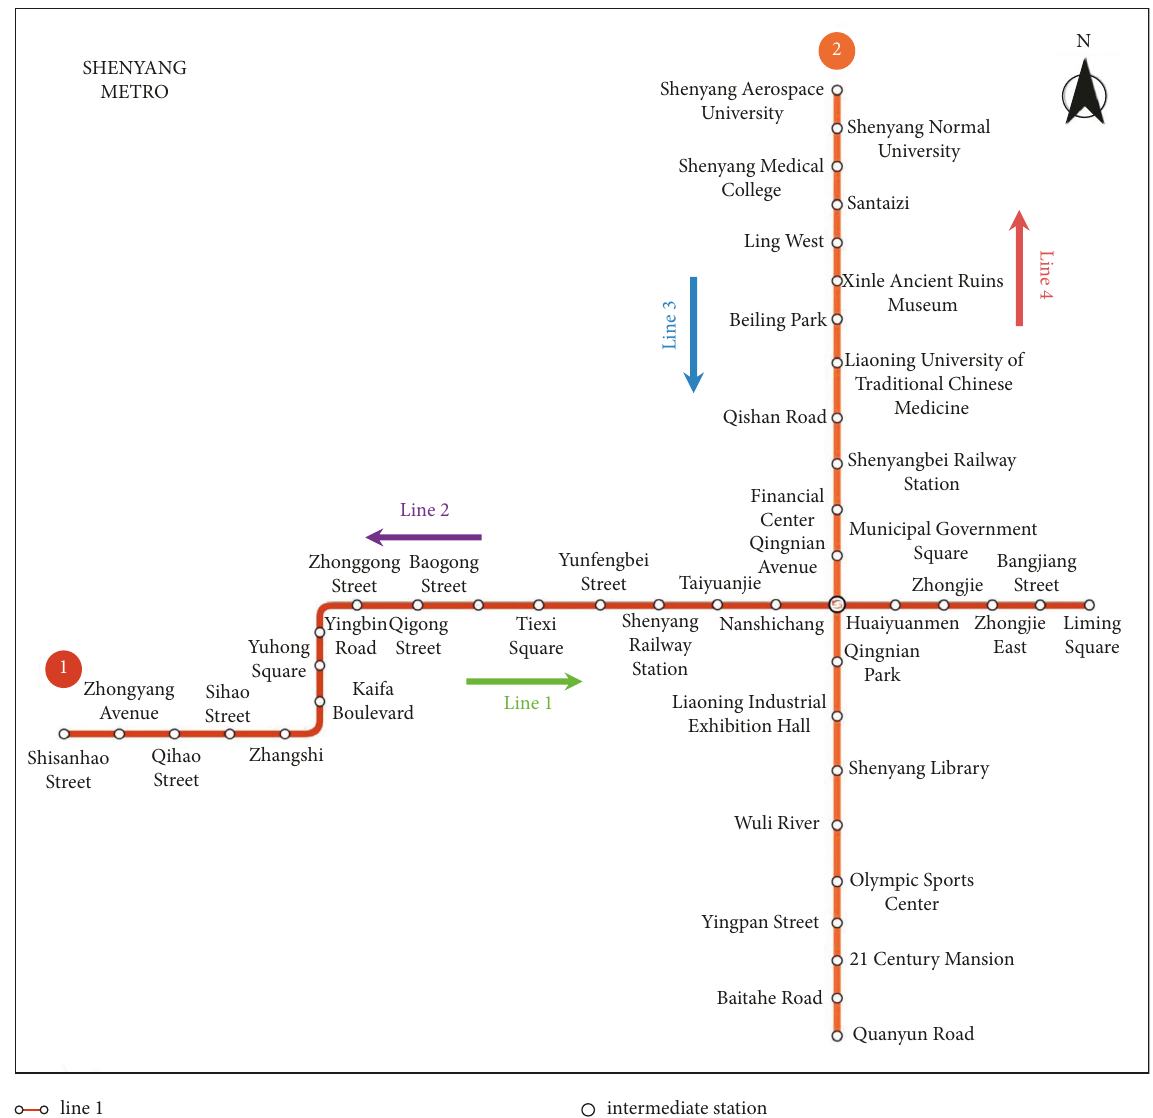
Figure 11: Illustration of Shenyang Metro